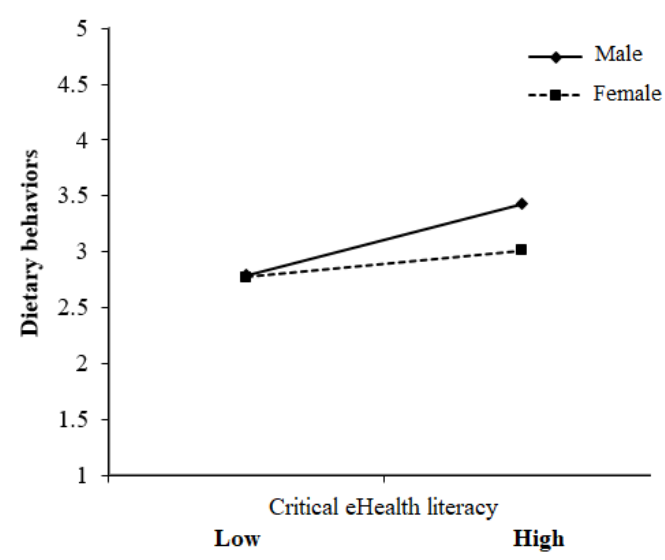
Figure 1. Influence of gender on critical eHealth literacy and dietary behaviors.